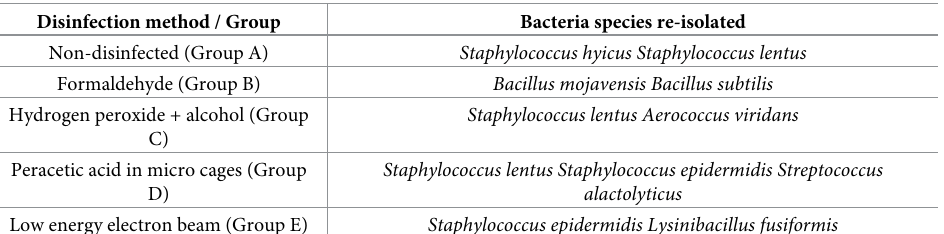
Table 4. Species identification of random isolates from control and disinfected groups using MALDI-TOF and 16S rRNA genomic